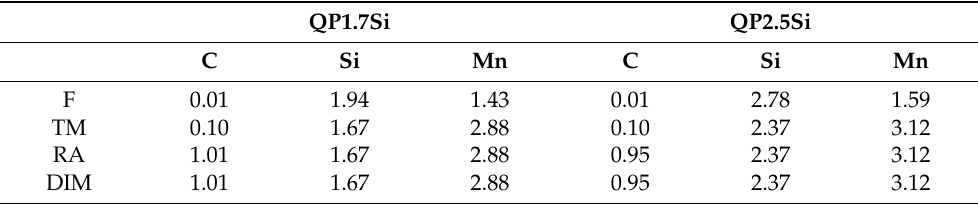
Table 1. Alloy concentrations in each phase (wt.%).